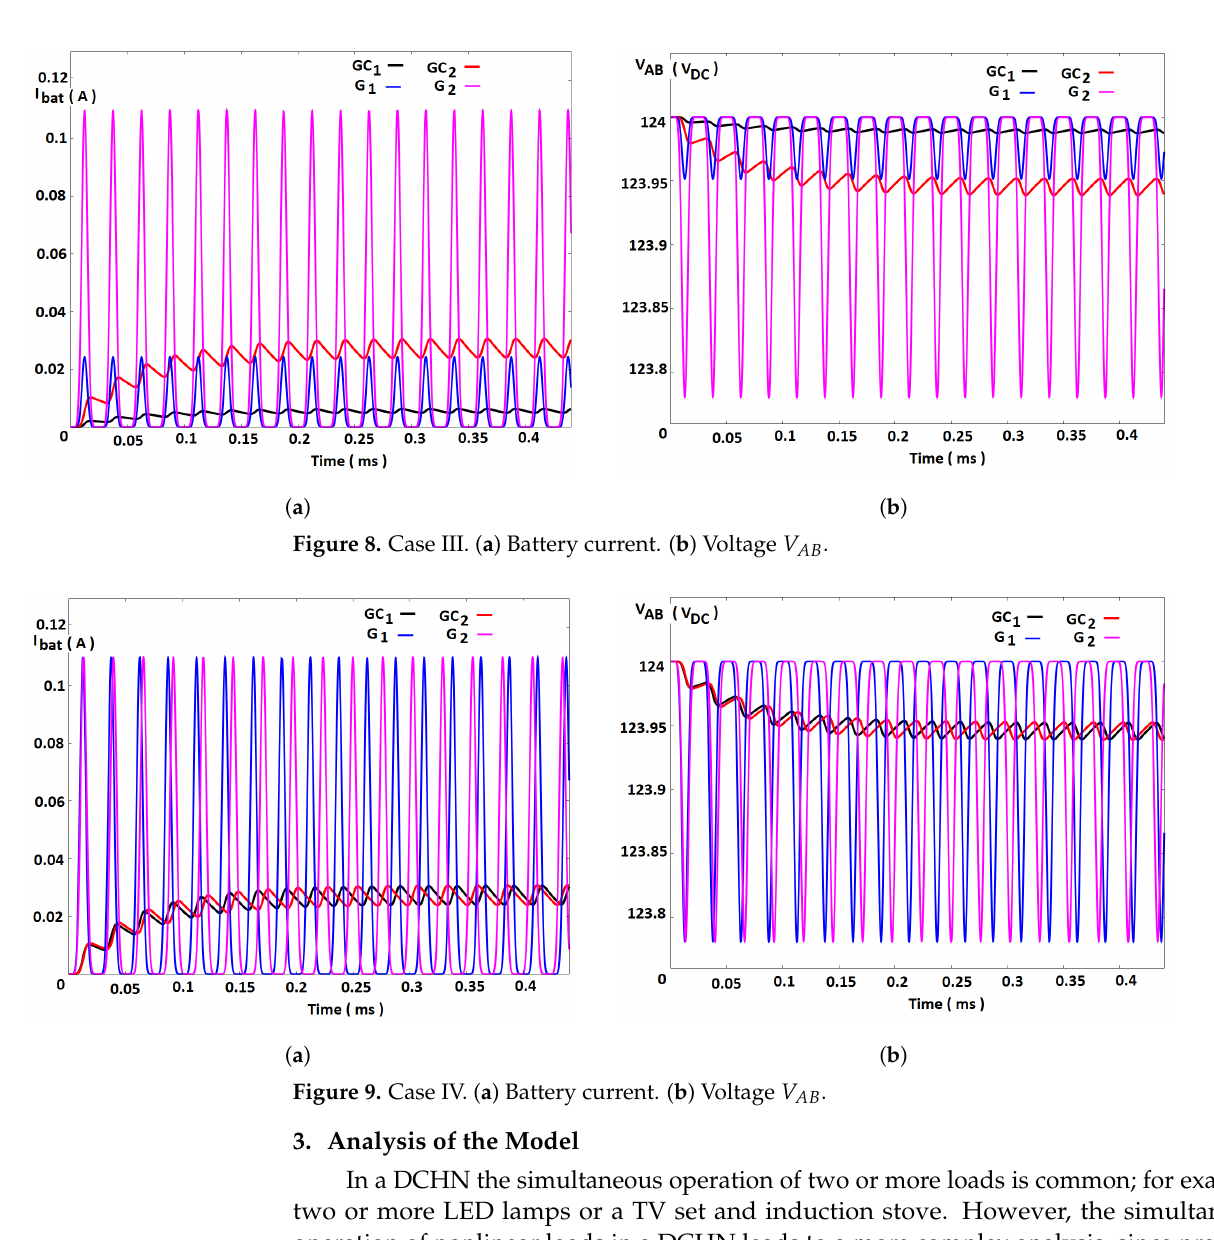
Figure 9. Case IV. ( a ) Battery current. ( b ) Voltage V AB